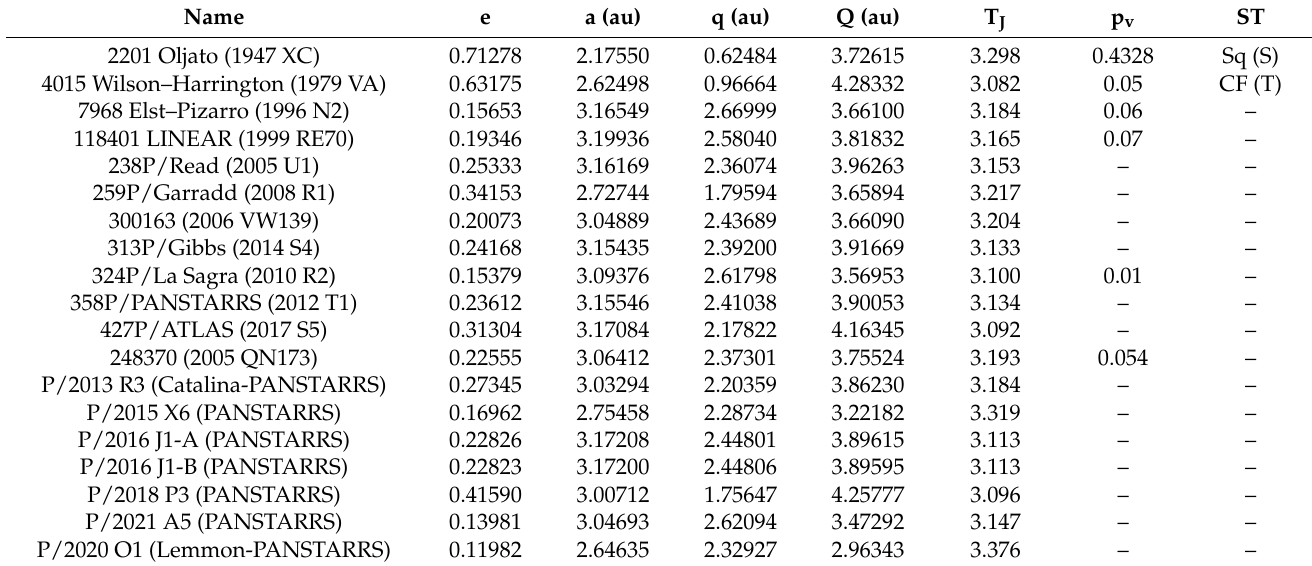
Table 1. Physical properties of the currently known MBCs. The table reports the name of the object as well as the eccentricity (e), the semi-major axis (a), the perihelion (q) and aphelion (Q) distances from the Sun, the Tisserand parameter with respect to Jupiter (T J ), the geometric albedo (p v ), and the spectral type (ST). In this last column, (S) indicates a SMASSII spectral type [18], while (T) stands for a Tholen spectral type [19]. Apart from P/2020 O1 (studied by Kim et al. [20]), all the remaining objects were reported by Jewitt and Hsieh [21], which the reader should consult for references to the studies of the various objects. Note that practically all of these objects have an aphelia beyond 3 au and in most cases even beyond 3.5 au, while the average eccentricity of these MBCs is 0.28. The data reported in this table were taken from the NASA/JPL Small-Body Database site